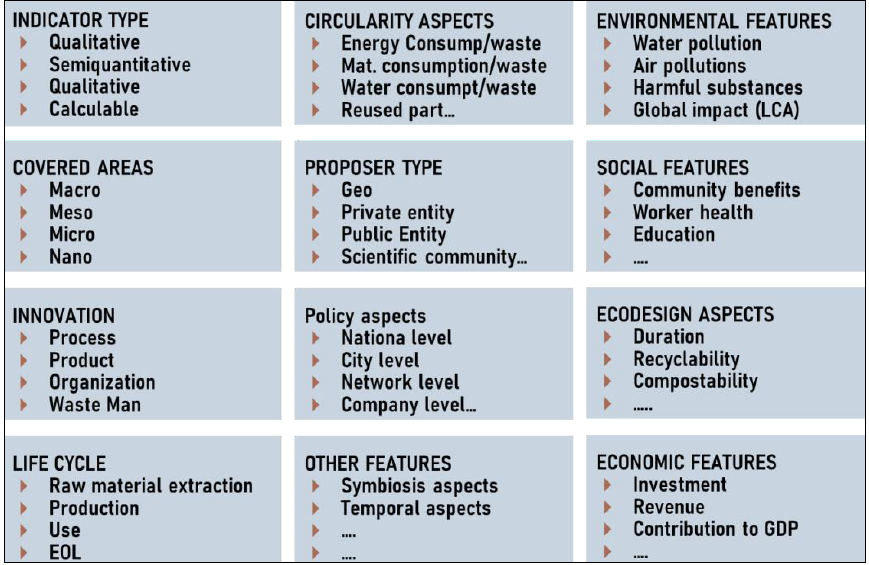
Figure 6: Example of Clustering